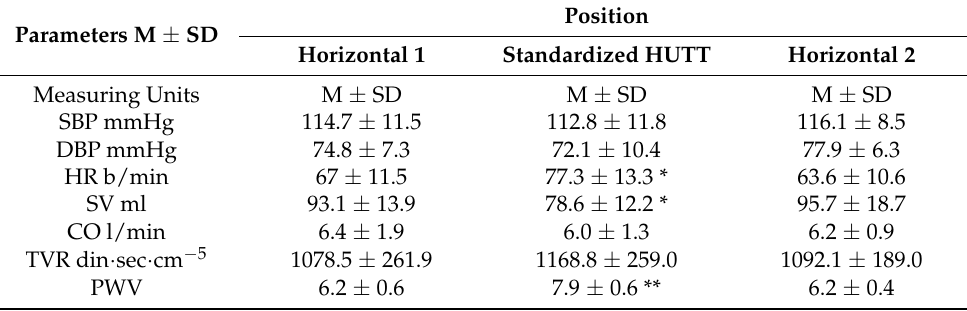
Table 2. Effects of HUTT challenge on selected parameters of the hemodynamics and pulse wave velocity